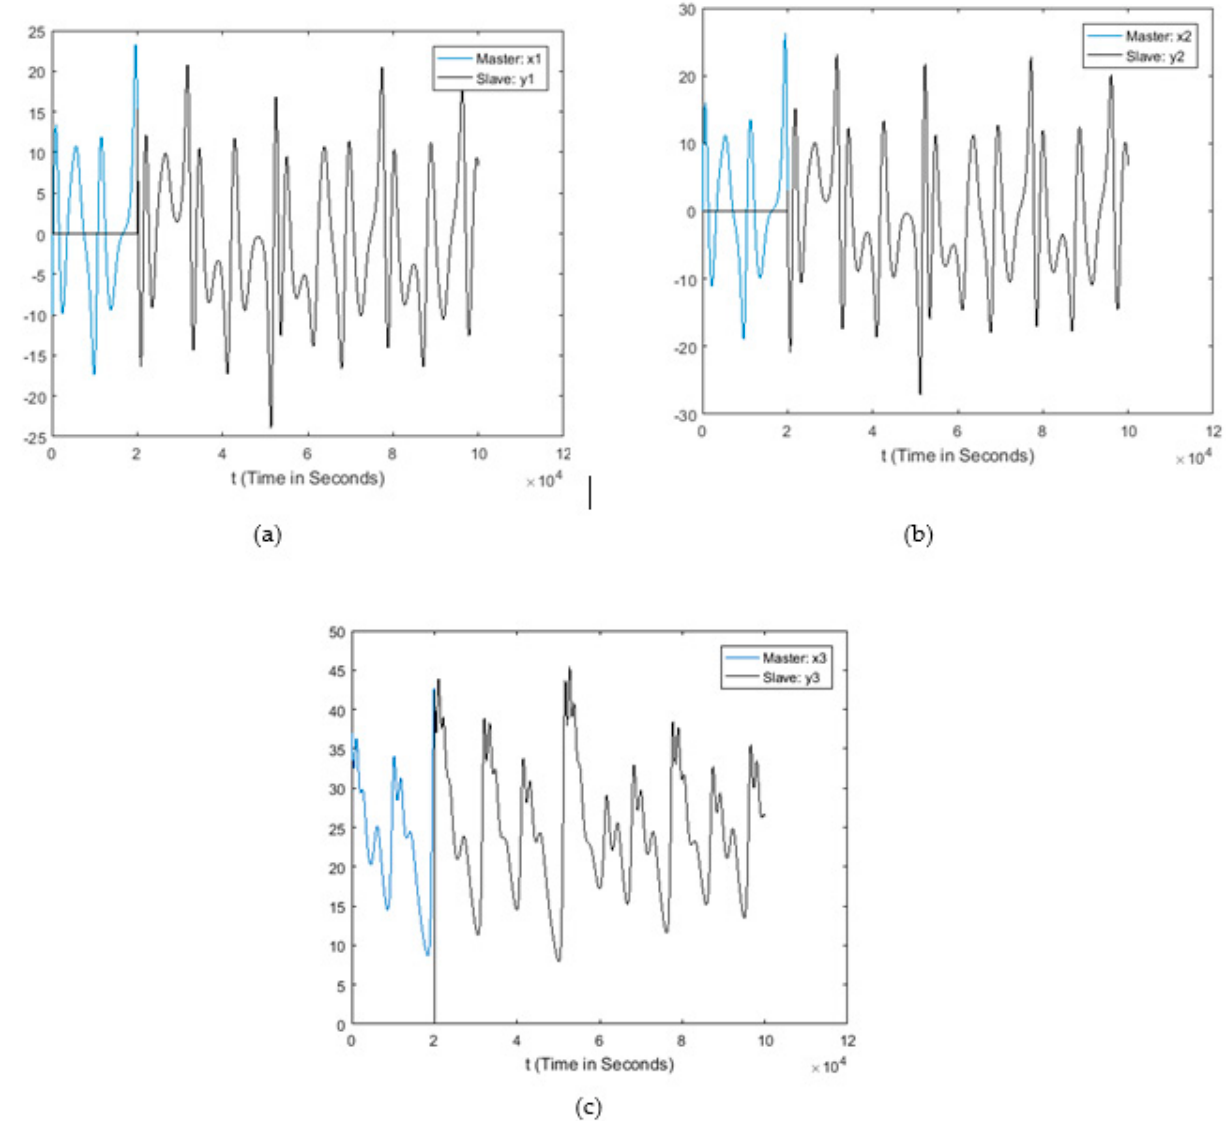
Figure 3. Time response ( a )–( c ) of synchronized states of master and slave.